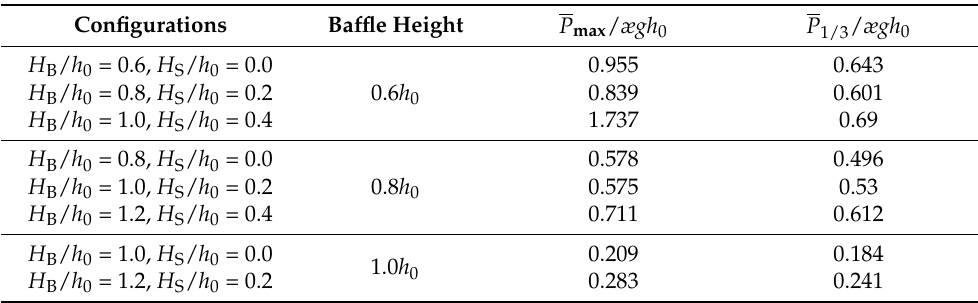
Table 2. The comparison of impact pressure for baffles with same height but different configuration ( T = 1.91 s, ω / ω 0 =